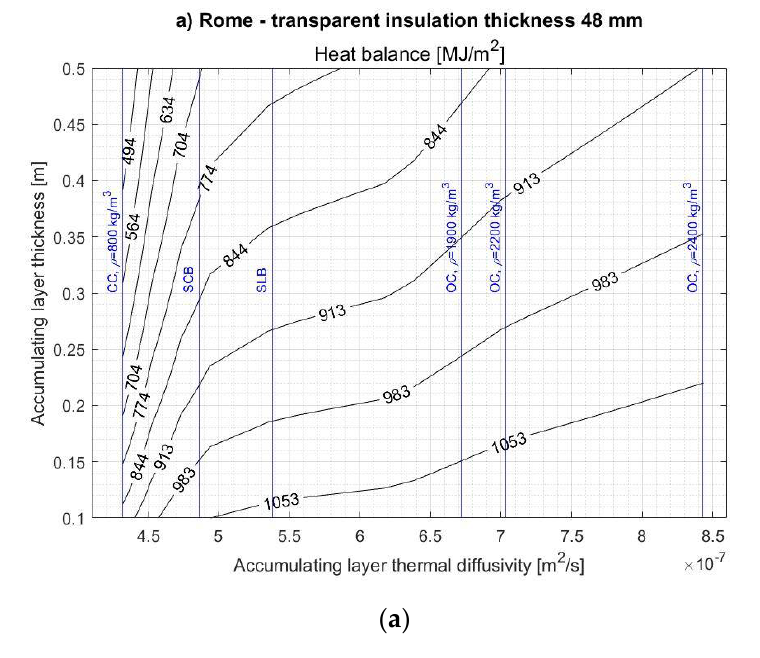
Figure A10. Cont